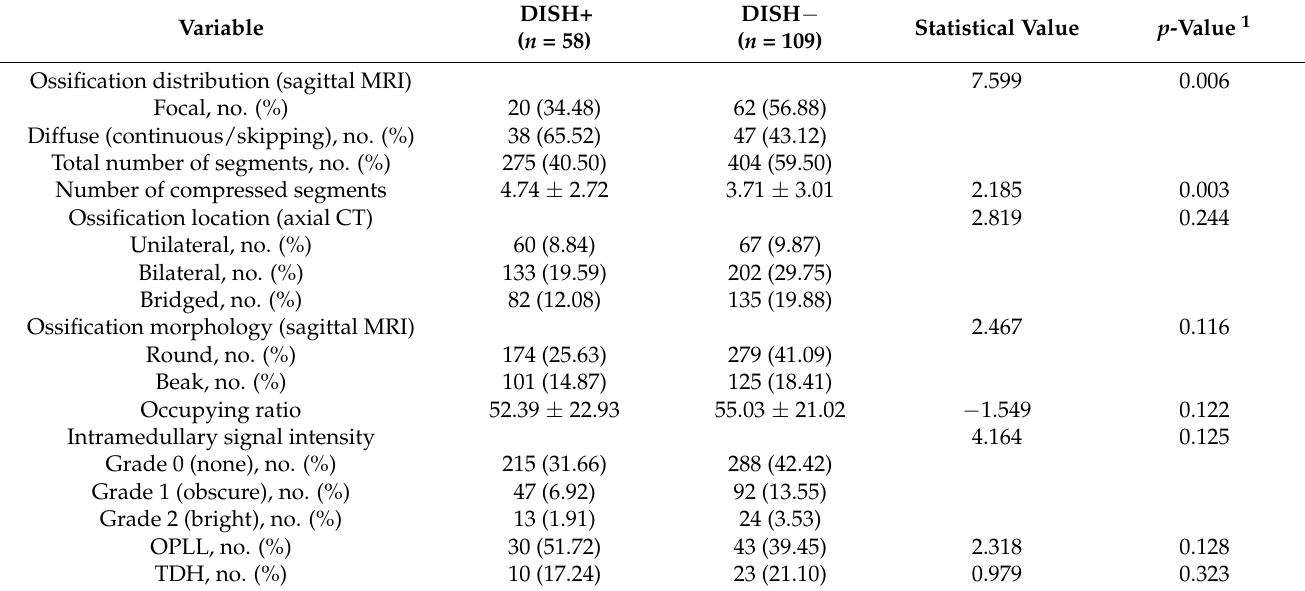
Table 3. Neuroimaging parameters of patients between the DISH+ and DISH − Group. TOLF distribution was divided into the focal type and diffuse type (continuous and skipping type). Total number of segments was defined as the number of ossification lesions of TOLF seen on CT or MRI. TOLF location was classified into three types (unilateral, bilateral, and bridged) on axial CT scan, and TOLF morphology fell into two types (round and beak) on sagittal MRI. Intramedullary high signal intensity (IHSI) at the narrowest level of the spinal cord were evaluated using the following grading: grade 0, none; grade 1, light; grade 2, intense.